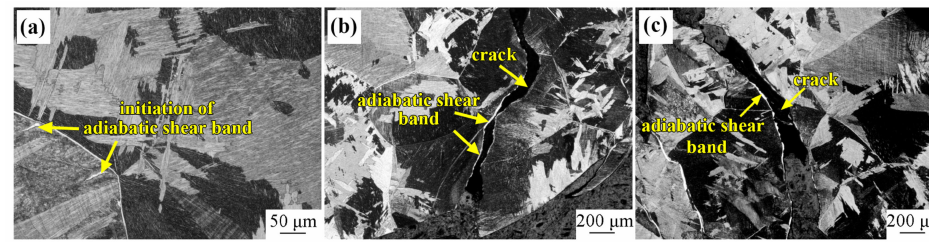
Figure 8. Microstructure of DM sample at different strain rates: ( a ) 1000 s − 1 ; ( b ) 2000 s − 1 ; ( c ) 3000 s − 1 .